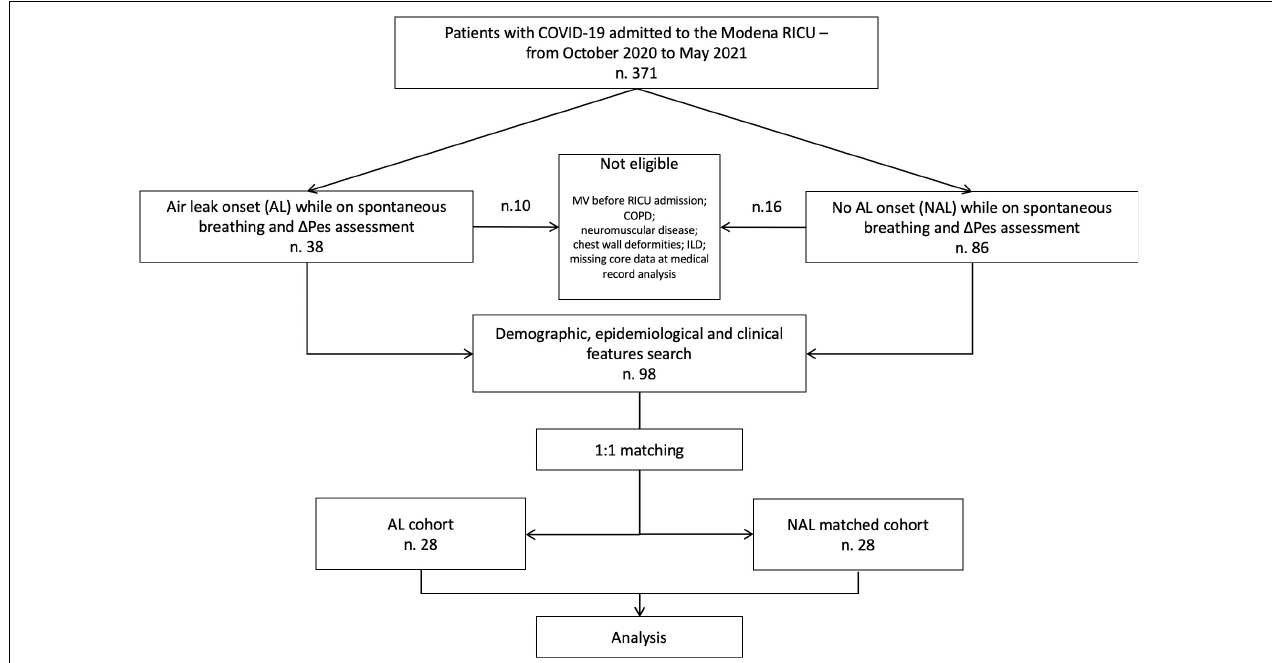
FIGURE 1 | Study algorithm. COVID-19, coronavirus disease 2019; RICU, respiratory intensive care unit; AL, air leak; NAL, non-air leak; COPD; chronic obstructive pulmonary disease; (cid:49) Pes, esophageal pressure